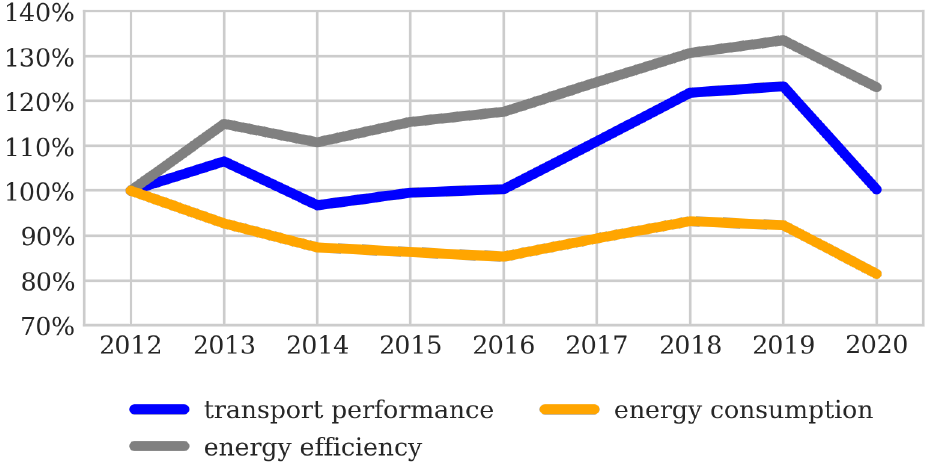
Figure 10. Transport performance, energy consumption and energy efficiency of DB Cargo Polska, normalized to 2012. Own study based on company